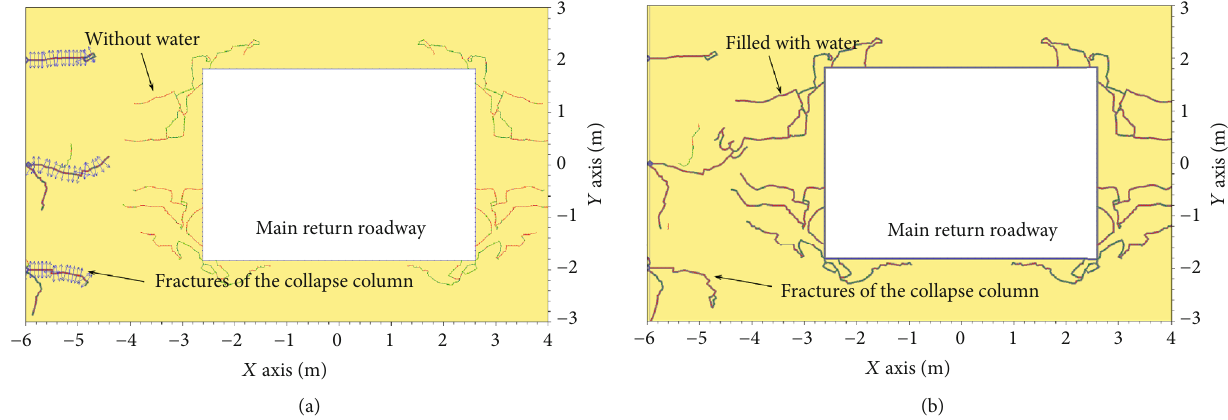
Figure 13: Modelled formation and development of water inrush channels (a) before and (b) after fracture